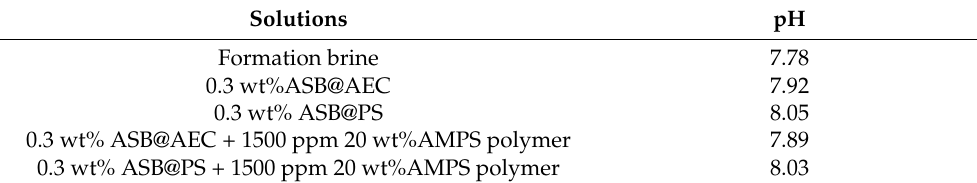
Table 2. pH of the EOR surfactant solutions prepared by formation brine (25 °C).